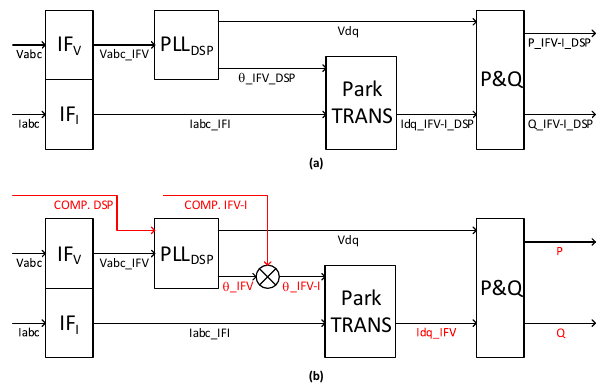
Figure 6. ( a ) PQ calculation without phase compensation, ( b ) PQ calculation with phase compensation.